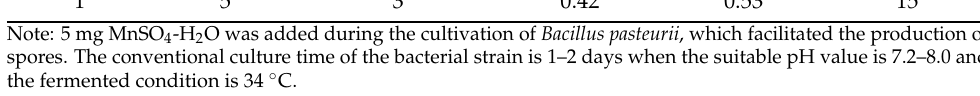
Table 1. Bacterial strain medium composition. UPW/L Peptone/g Meat Extracts/g NaHCO 3 /g Na 2 CO 2 /g Agar/g